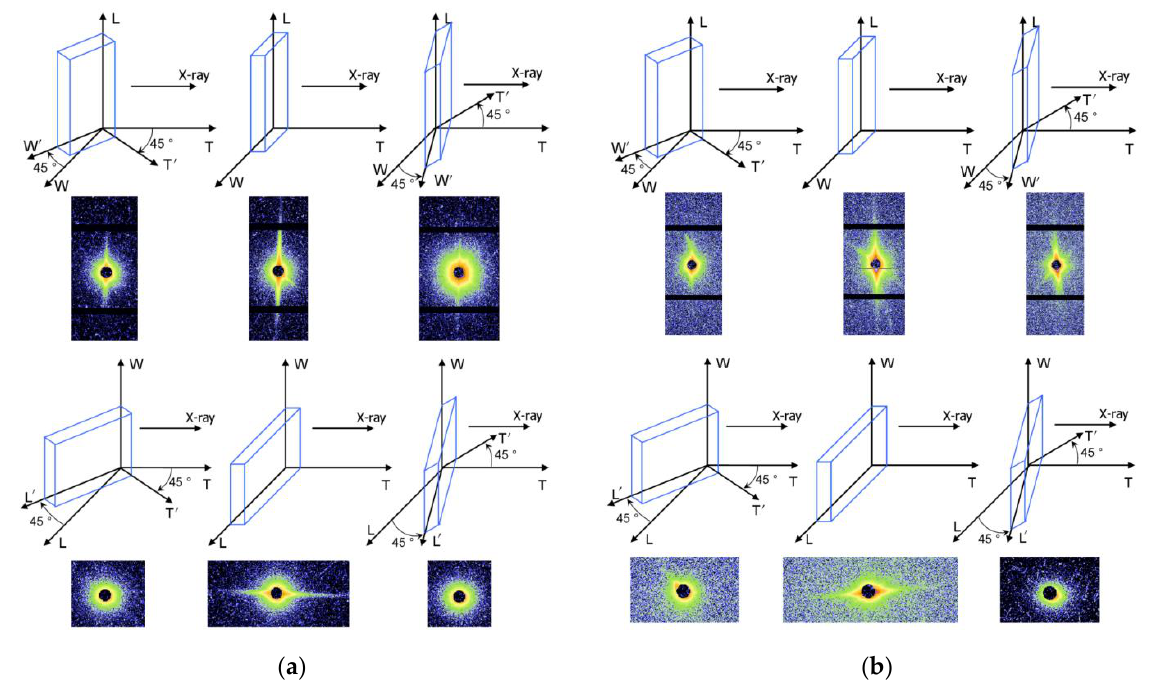
Figure 2. SAXS patterns of nano-scale crystal defects in explosive single crystal changing with sample stage rotating: ( a ) In RDX single crystal, ( b ) in HMX single crystal.